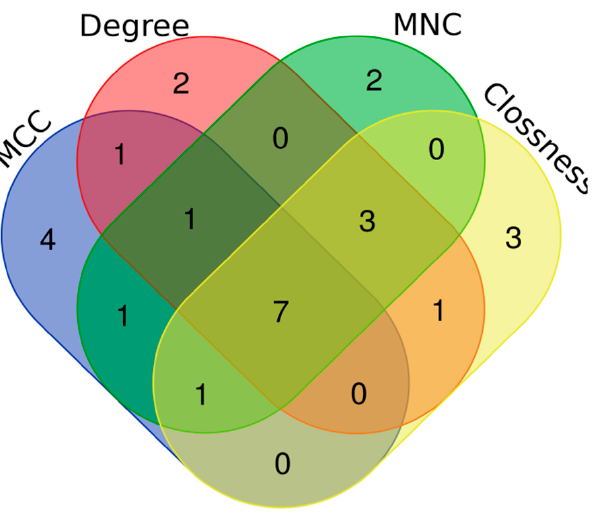
Figure 5. Venn plot to identify significant hub genes created by four centrality algorithms. Areas with different colors are related to different methods. The cross areas show the common DEGs. There are seven genes in concurrent areas.